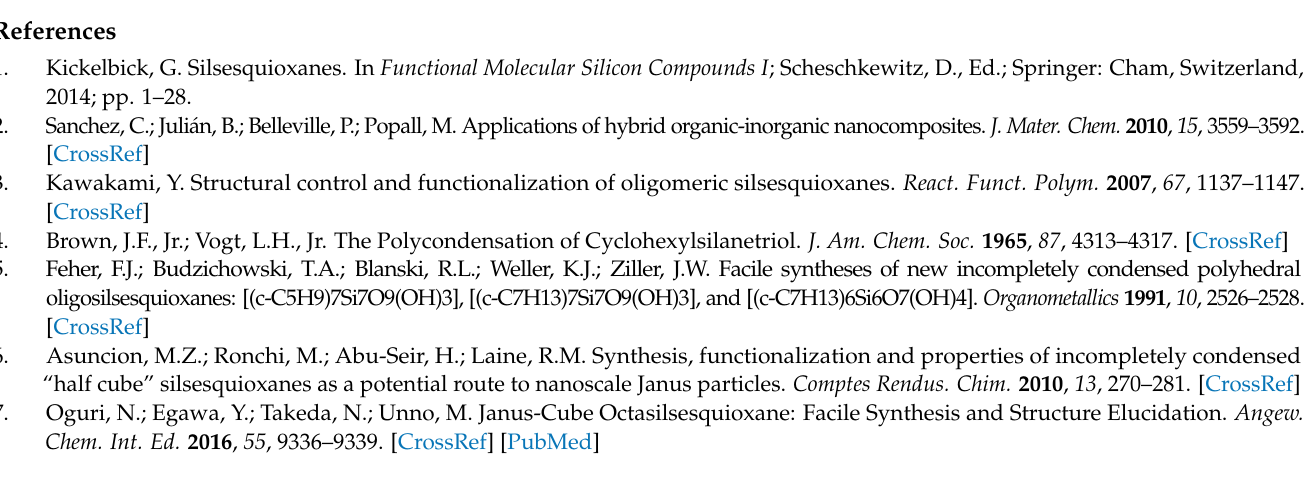
Figure S7: 1 H NMR spectrum of J1 (CDCl 3 ); Figure S8: FTIR spectra of J1 (dark blue) J2 (light blue) and J3 (green); Figure S9: 1 H NMR spectrum of J2 (CDCl 3 ); Figure S10: 1 H NMR spectrum of J3 (CDCl 3 ); Figure S11: 13 C NMR spectrum of J3 (CDCl 3